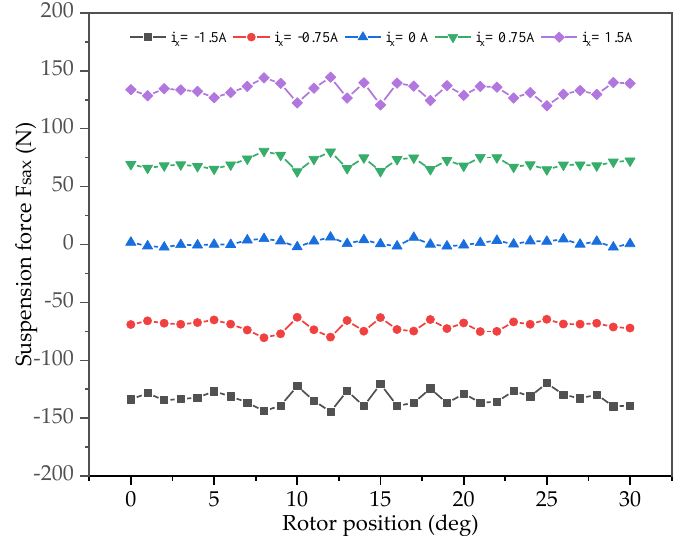
Figure 2. Basic suspension characteristics of the proposed machine.